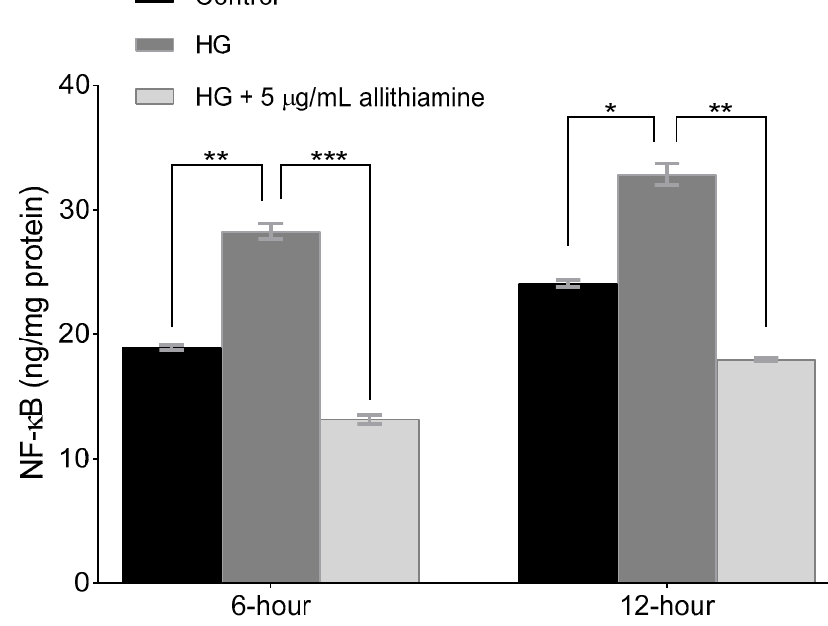
Figure 5. Effect of allithiamine on the activation of NF- κ B in HUVECs after 6 and 12 h. Data are expressed as the mean ± SEM of three individual experiments *, **, and *** mark significant ( p < 0.05, p < 0.005, and p < 0.0005) differences between the control and HG, and between HG and HG+5 μ g/mL allithiamine, HG: hyperglycaemia (30 mMol/L glucose).